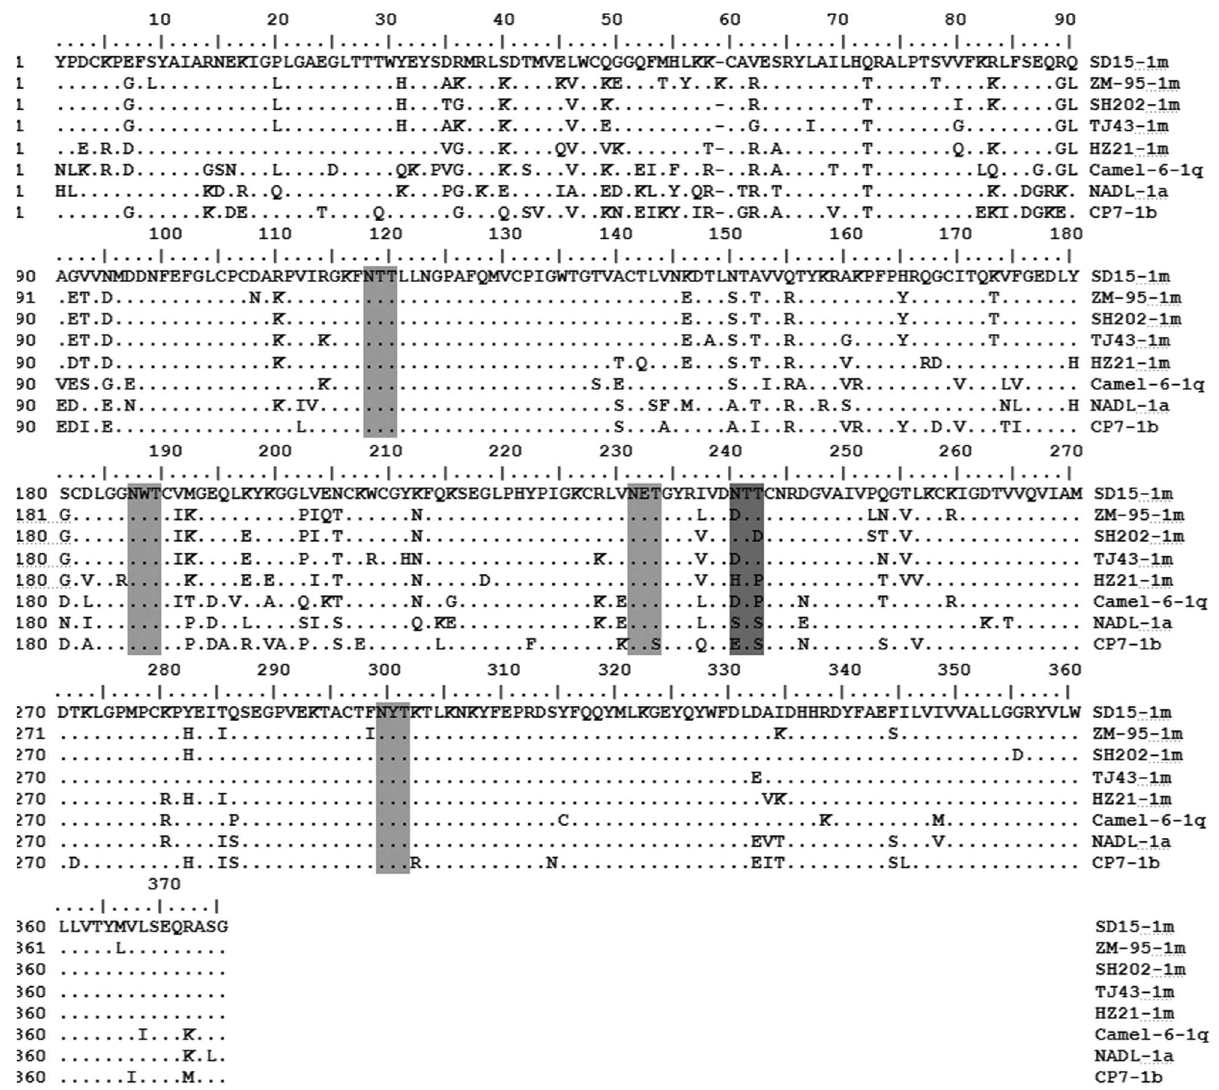
Fig 5. A unique glycosylation site revealedwithin SD-15-encoded E2 amino acid sequence. Potential glycosylation sites within E2 amino acid sequenceof SD-15 were predicted using NetNGlyc 1.0 Server software. An extra and uniqueglycosylation site was revealed at 240NTT only in SD-15 strain in additionto four conserved glycosylation sites shared with all BVDV-1 strains examined. The glycosylation sites shared by all BVDV-1 examinedwere less lightly shadowedthan the uniqueglycosylation site in SD-15.